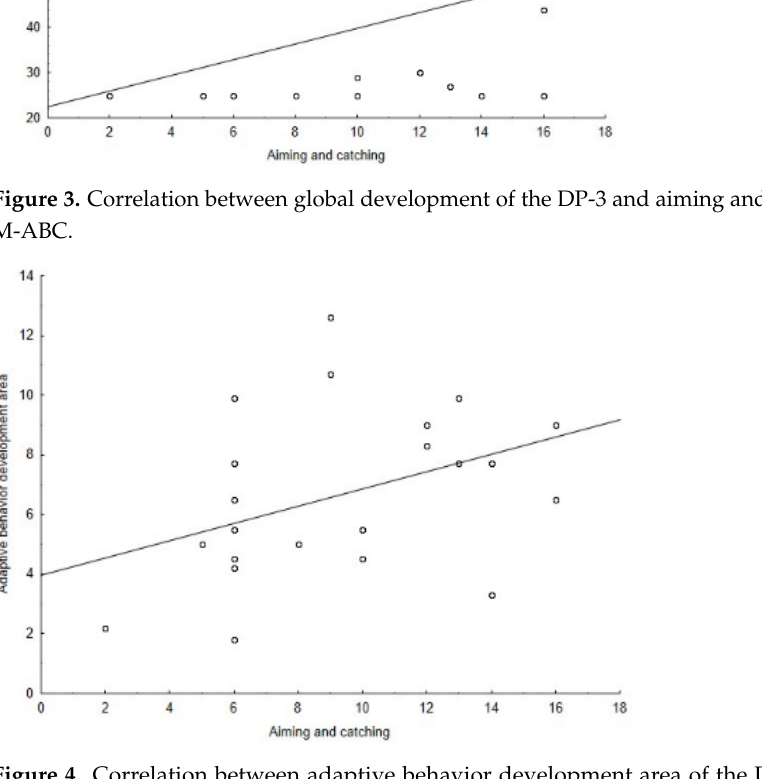
Figure 4. Correlation between adaptive behavior development area of the DP-3 and aiming and catching skills of the M-ABC.